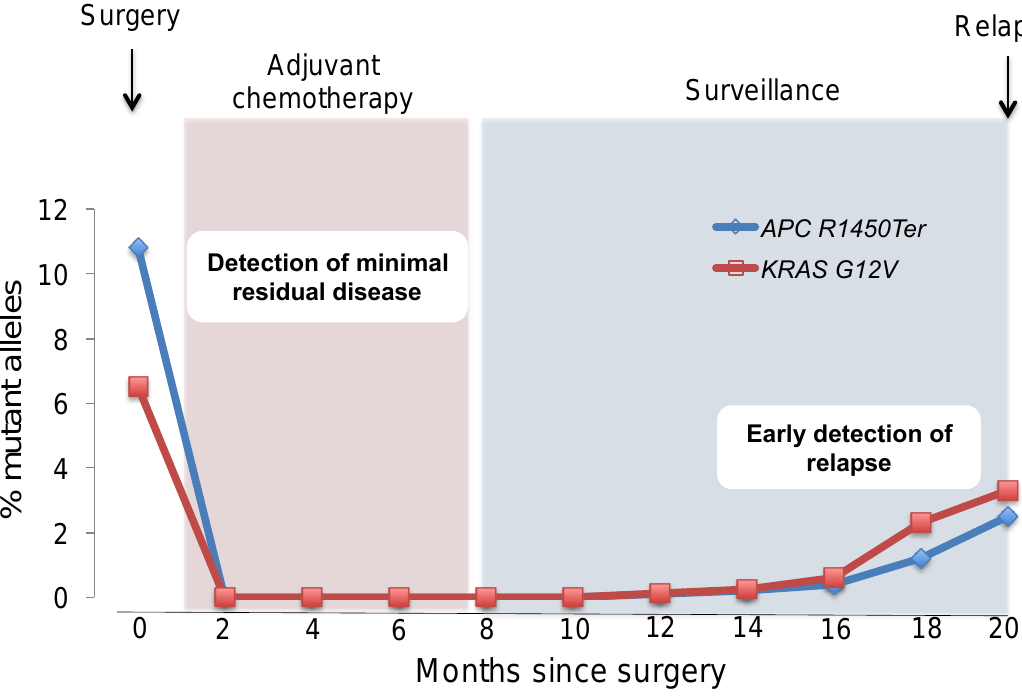
Figure 1. Minimal residual disease (MRD) monitoring and early diagnosis of relapse. Liquid biopsy approaches might be well suited to measuring MRD, as residual tumor components can be detected with high sensitivity. Because MRD-positive patients have higher risk of relapse, early diagnosis of relapse may improve patient outcomes. This figure reflects a representative case of our own original data.